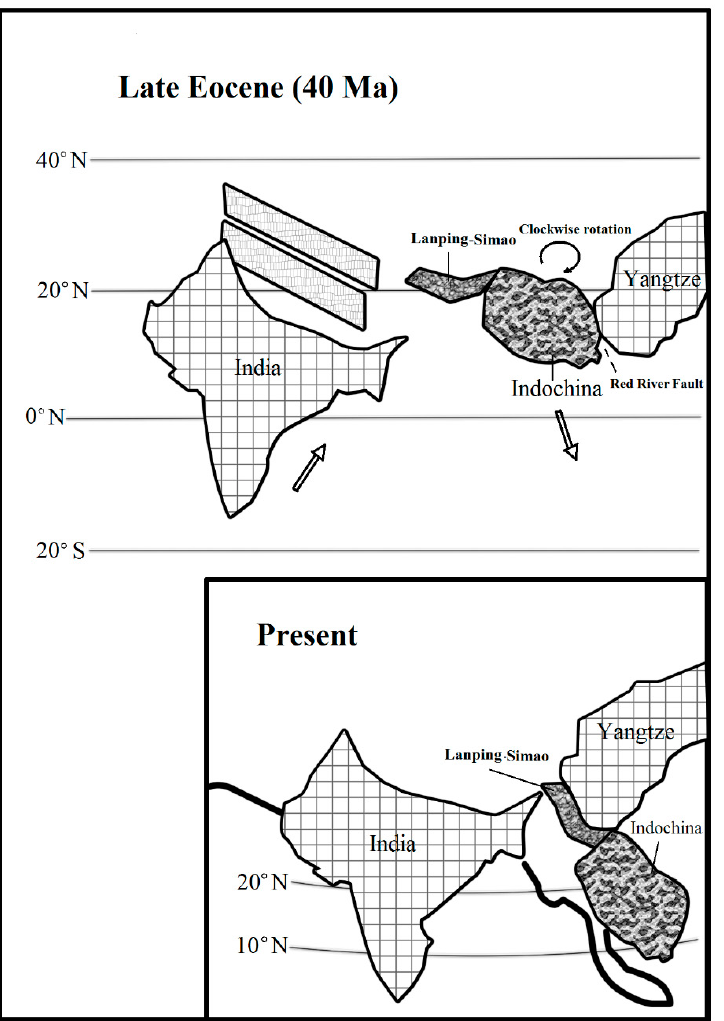
Figure 8. Clockwise rotation and southeastward extrusion of the Lanping ‐ Simao and Indochina geoblocks during the late Eocene (redrawn from Sato et al., 2001, Figure